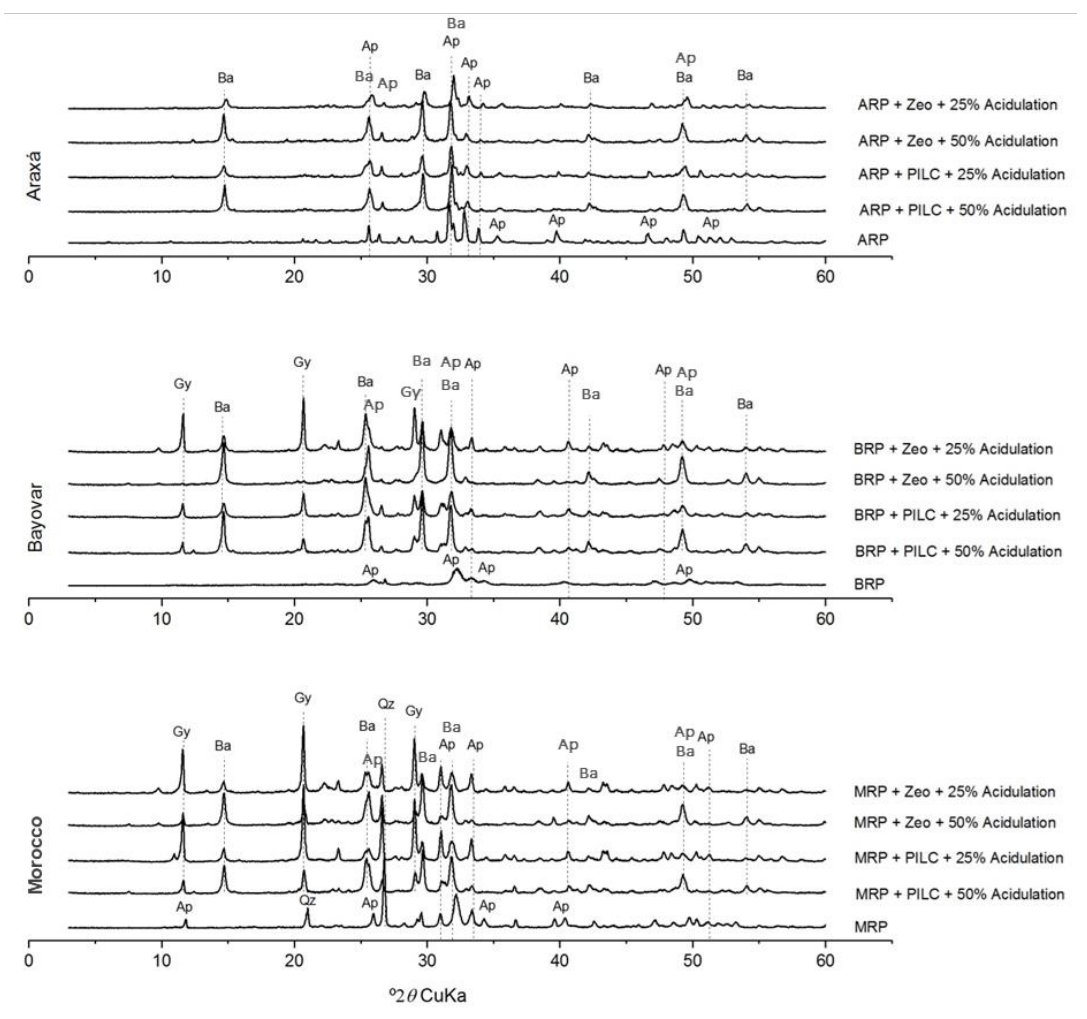
Figure 2. X-ray diffractograms of pure and acidulated RP (25 and 50% ac.) with the incorporation of pillared clay (PILC) or zeolite (Zeo), powder blades. ARP = Araxá Rock Phosphate; BRP = Bayovar Rock Phosphate; MRP = Morocco Rock Phosphate; PILC = pillared clay; Zeo = zeolite. Identified minerals: Ap = apatite; Qz = quartz; Gy = gypsum; Ba = bassanite.